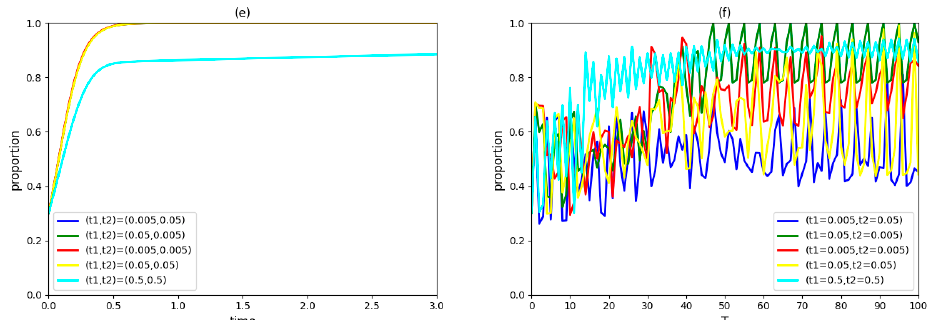
Figure 3. ( a ) The evolutionary paths of enterprise strategies with different government subsidy coefficients. ( b ) The proportion of cooperative enterprises in the region over time. ( c ) The evolutionary paths of university/institute strategies with different government subsidy coefficients. ( d ) The proportion of cooperative universities/institutes in the region over time. ( e ) The evolutionary paths of government strategies with different government subsidy coefficients. ( f ) The implementation of the proportion of the government adopting a participation strategy in the region over time.